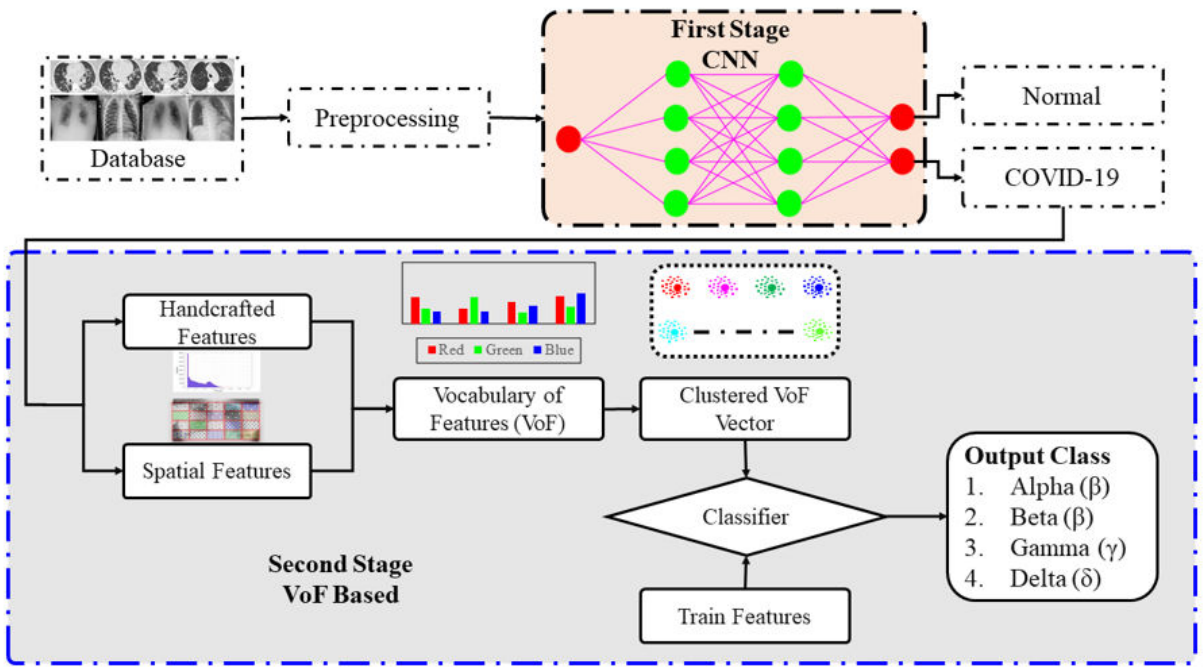
Figure 2. Proposed framework for the classification of COVID-19